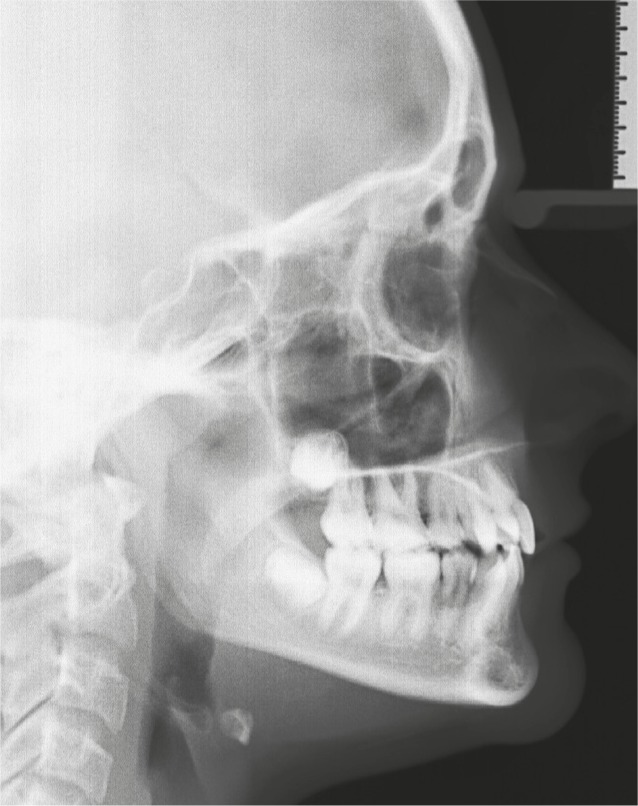
Final cephalogram.